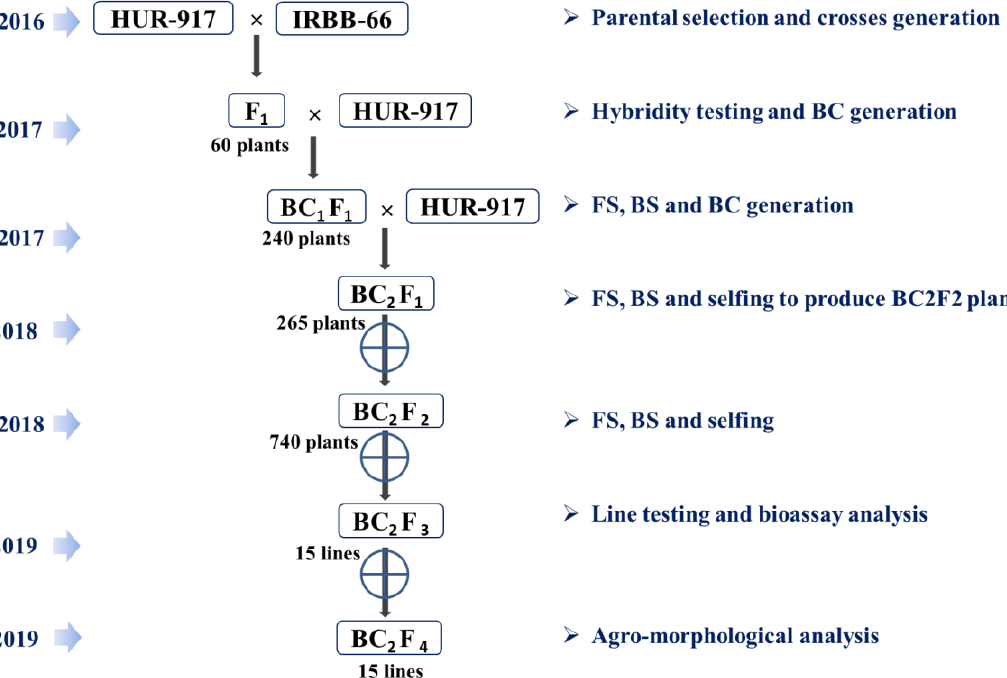
Figure 1. Marker-aided breeding strategy followed for the development of improved HUR